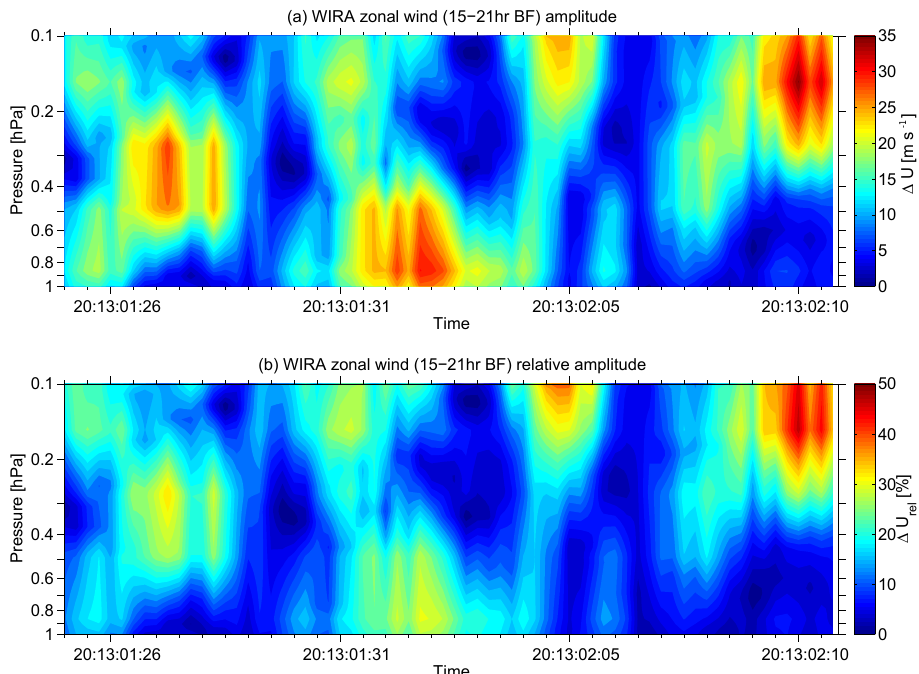
Figure 9. WIRA zonal wind band-pass-filtered (15–21h) absolute (a) and relative (b) wave amplitudes in the pressure range 0 . 1–1hPa between 25 January and 10 February